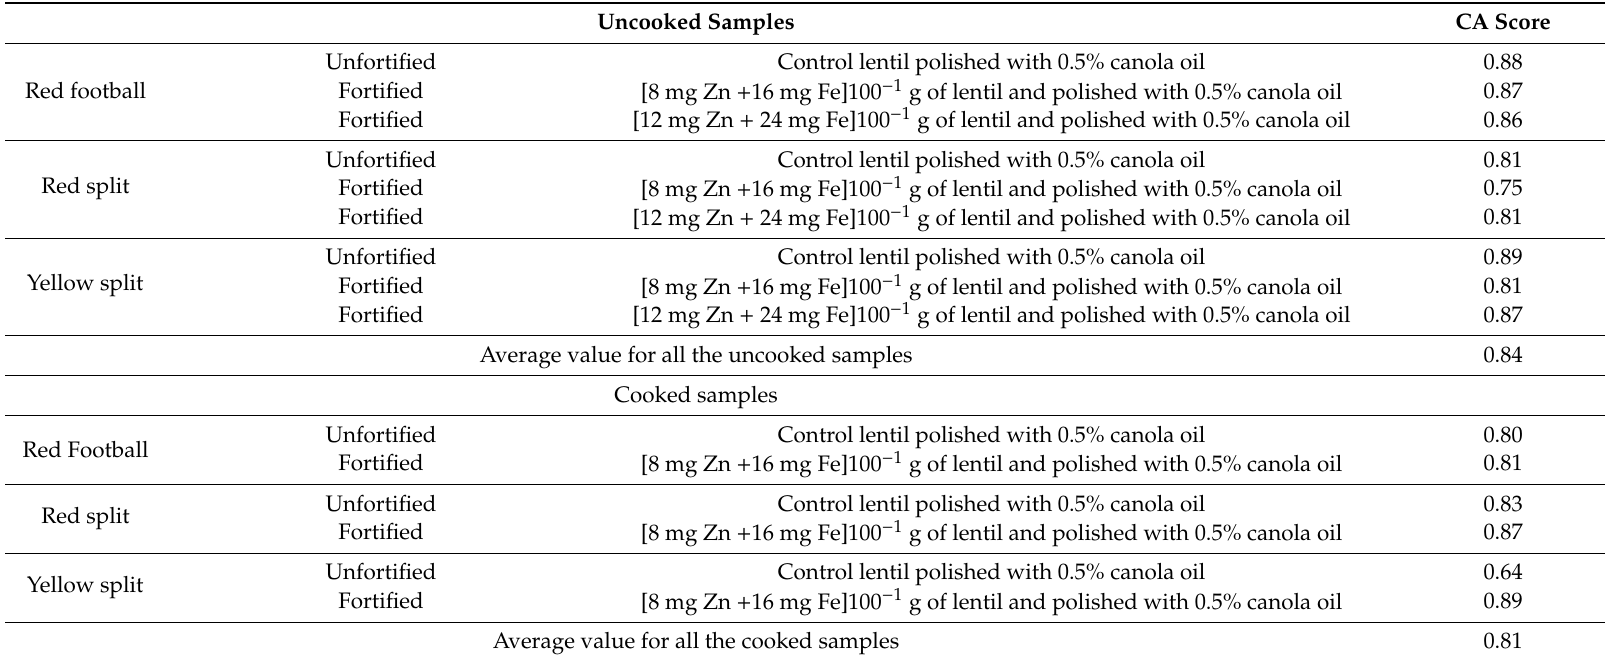
Table 5. Internal consistency reliability (CA) of the sensory panelists’ ratings of uncooked red football, red split and yellow split lentil and cooked dal